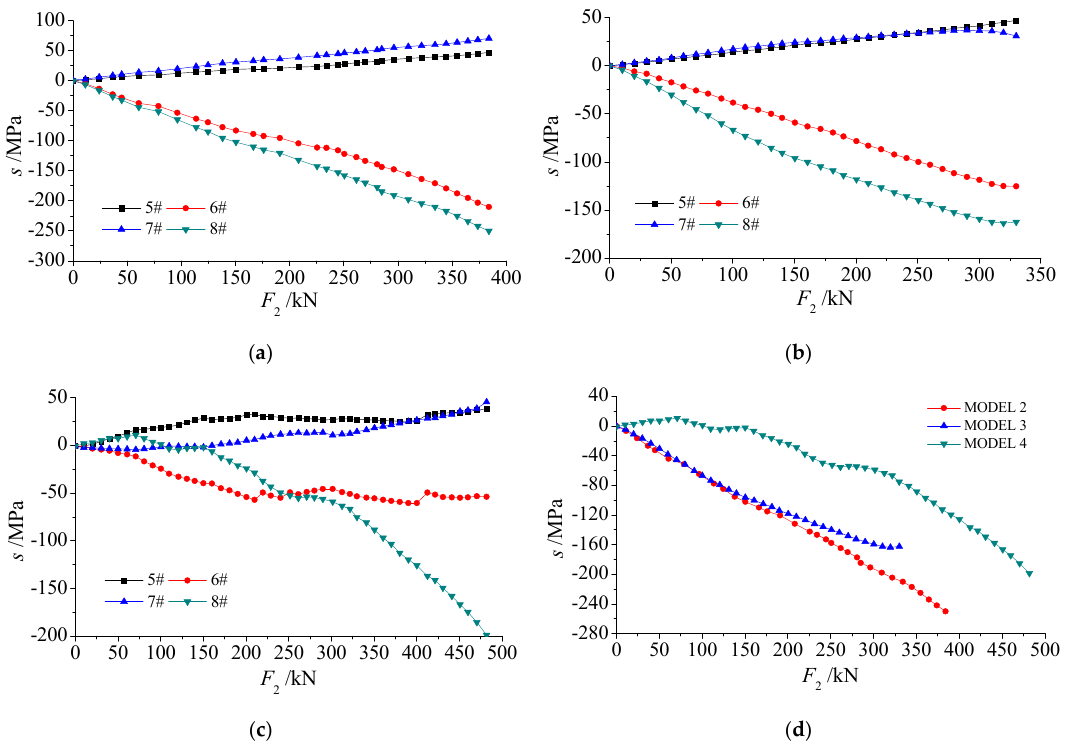
Figure 14. Stresses in floor beam: ( a ) stresses in model 2; ( b ) stresses in model 3; ( c ) stresses in model 4; and, ( d ) comparison of stresses of gauge 8.